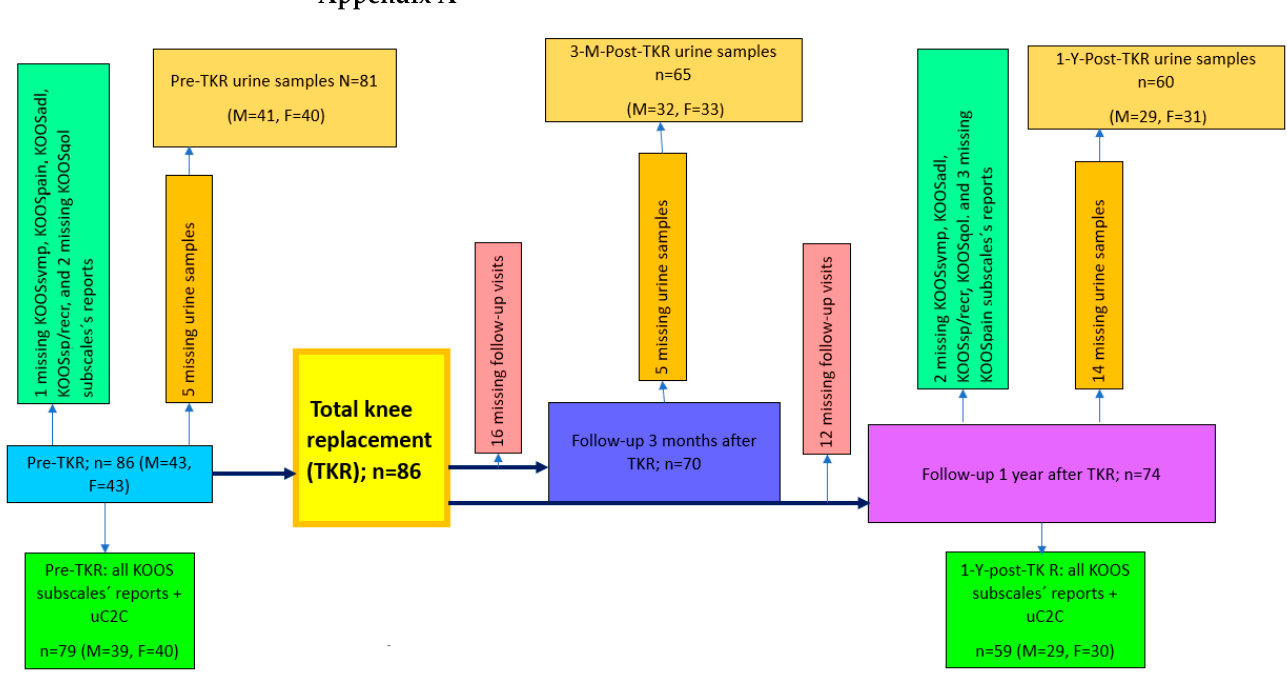
Figure A1. Flowchart that details the study procedure and formation of the patient cohort. n—numbers of whole group; M—number of males; F—number of females.